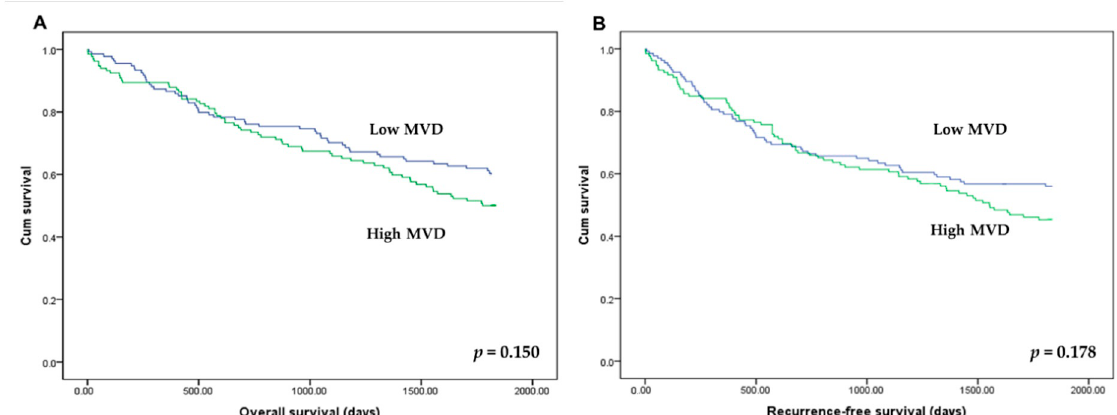
Figure 4. Kaplan–Meier curves for overall survival ( A ) and recurrence-free survival ( B ) according to the microvessel den- sity (MVD). Patients with high (green line) and low MVD (blue line) showed overall and recurrence-free survivals.